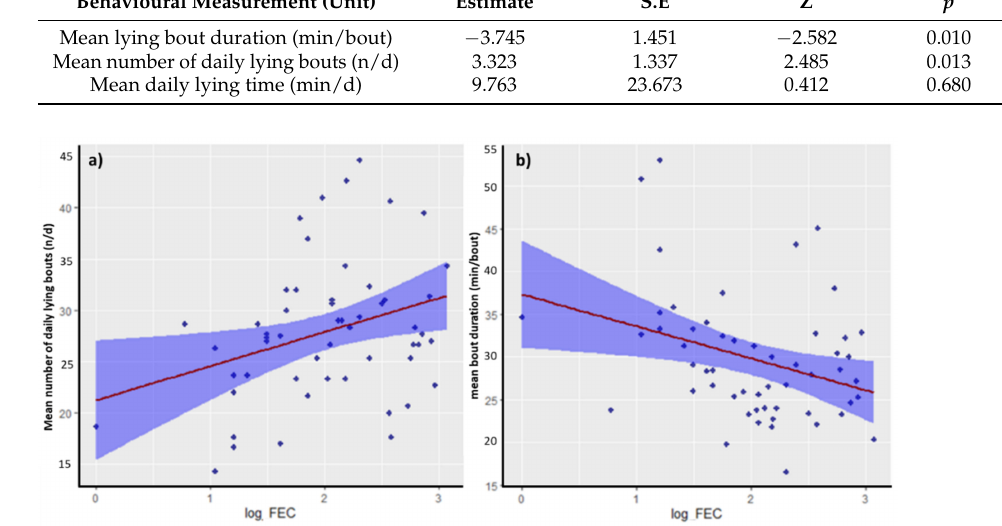
Table 2. Linear mixed models of the association between log FEC and behavioural measurements (number of daily lying bouts, lying bout duration and daily lying time) of periparturient ewes. Behavioural Measurement (Unit)